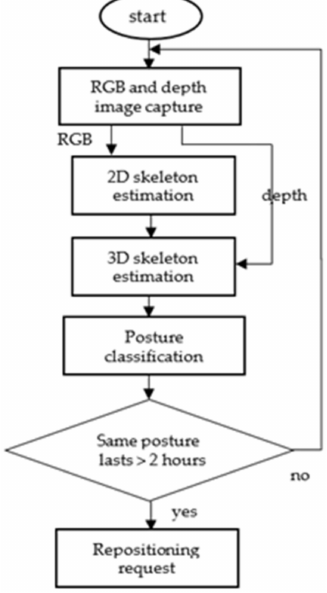
Figure 1. The framework of the proposed